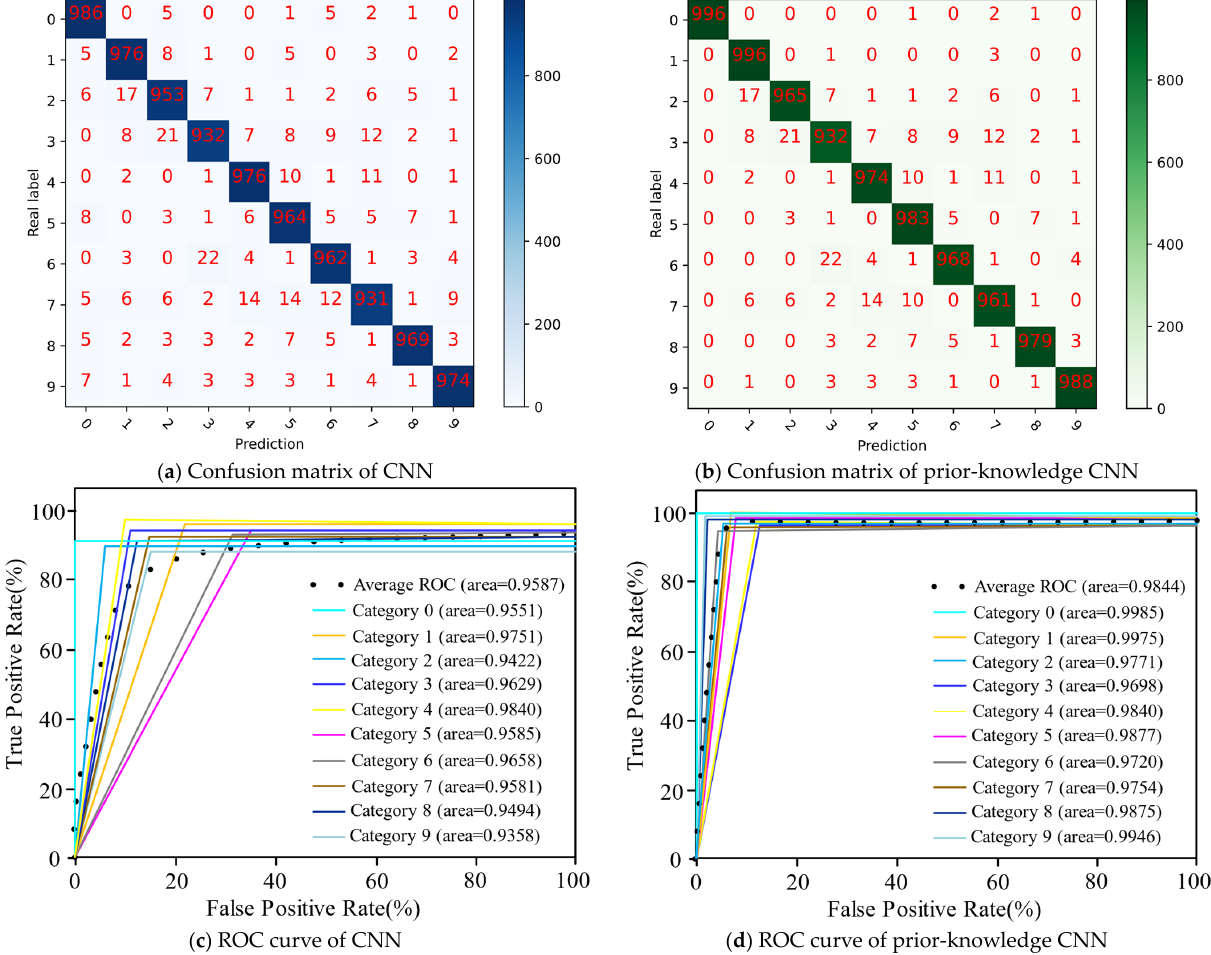
Figure 5. Diagnosis effect comparison of CNN and prior-knowledge CNN for different fault types.